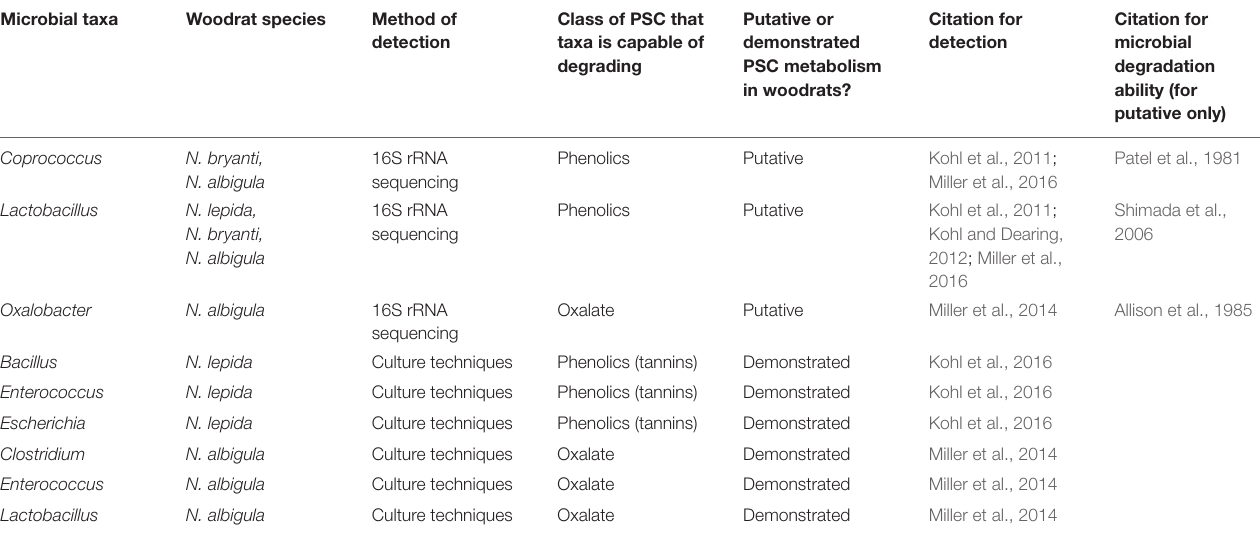
TABLE 2 | Summary of evidence for detoxifying microbes in the woodrat